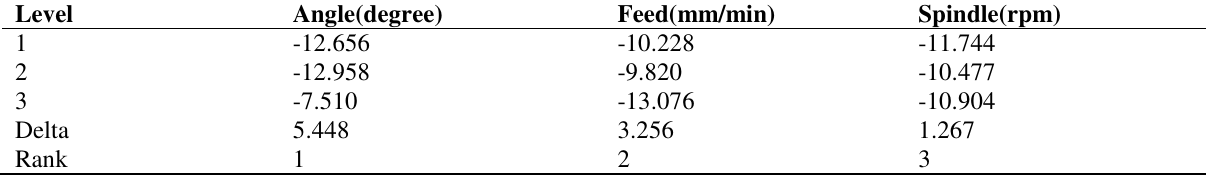
Table for signal to noise ratios for bronze smaller is